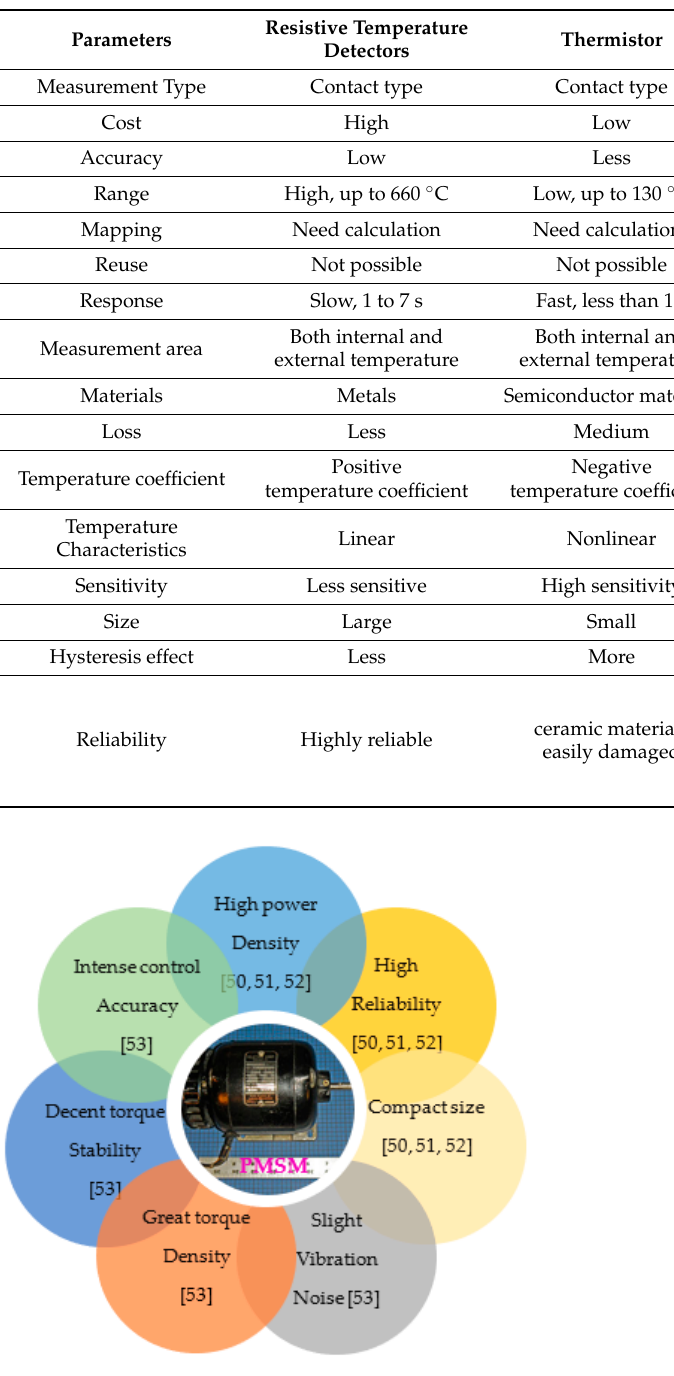
Figure 7. Special features of permanent magnet synchronous motor